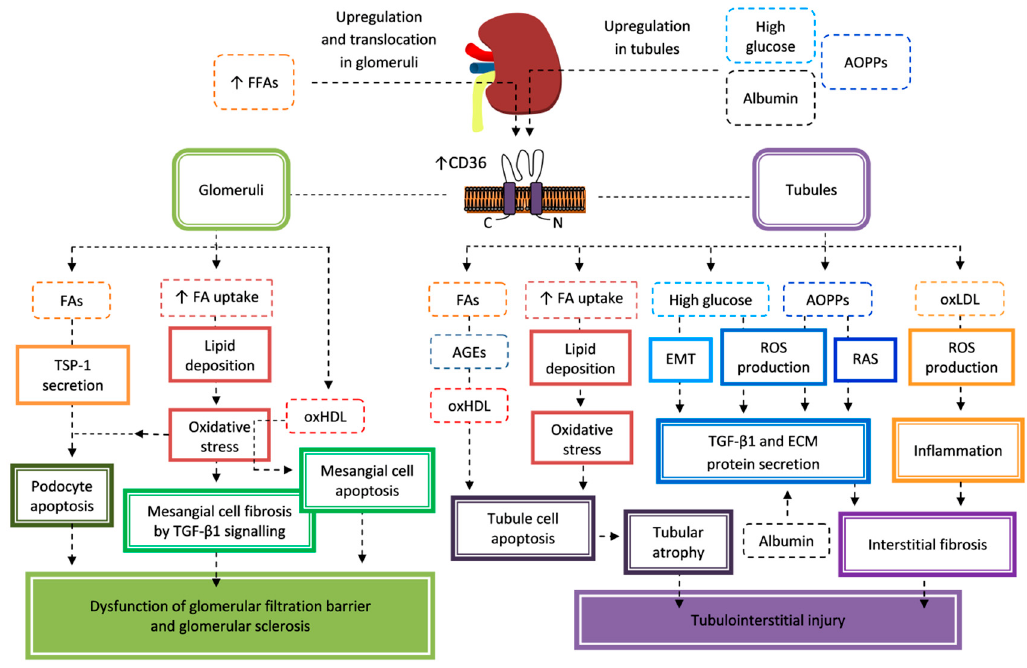
Figure 3. The contribution of CD36 to the pathogenesis of diabetic nephropathy (DN). CD36 is involved in both glomerular and tubular damage in diabetes mellitus (DM). Increased fatty acid (FA) uptake with lipid deposition is the main cause of glomeruli damage by induction of podocyte apoptosis, but also causes the initiation of glomeruli sclerosis by transforming growth factor β 1 (TGF- β 1) signaling. Moreover, oxidized high-density lipoprotein (oxHDL) induces mesangial cell apoptosis. These e ff ects promote the dysfunction of the glomerular filtration barrier. Many more factors are involved in tubule cell damage. As with podocytes, apoptosis is induced by lipotoxicity in tubule cells. Furthermore, hyperglycemia, the products of lipid and protein oxidation (oxHDL, oxidized low-density lipoprotein (LDL), advanced oxidation protein products (AOPPs), and advanced glycation end products (AGEs)) mediate apoptosis of tubular cells or fibrosis of the interstitium, resulting in tubulointerstitial injury. Interstitial fibrosis is initiated by the epithelial-to-mesenchymal transition (EMT) in response to hyperglycemia, but also the secretion of TGF- β 1 and extracellular matrix (ECM) protein mediated by reactive oxygen species (ROS), or activation of the renin-angiotensin system (RAS) in response to AOPPs and oxLDL. These various CD36-dependent mechanisms ultimately lead to a progressive loss of kidney function in